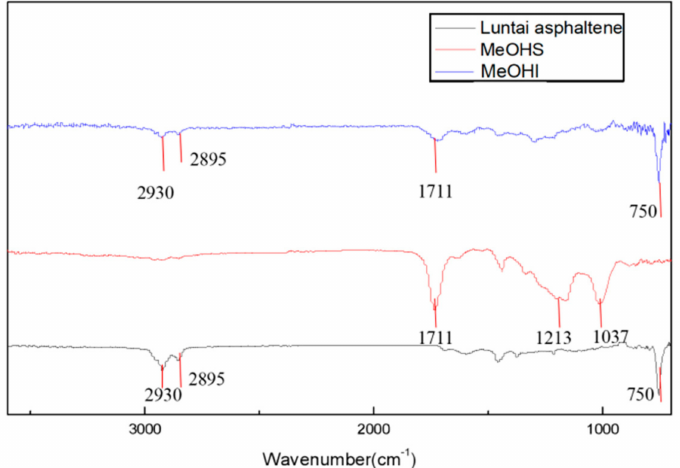
Figure 1. The infrared spectra of Luntai asphaltene, MeOHS, and MeOHI after oxidation reaction: the black line indicates Luntai asphaltene, the red line represents MeOHS, and the blue line shows MeOHI after the oxidation reaction.